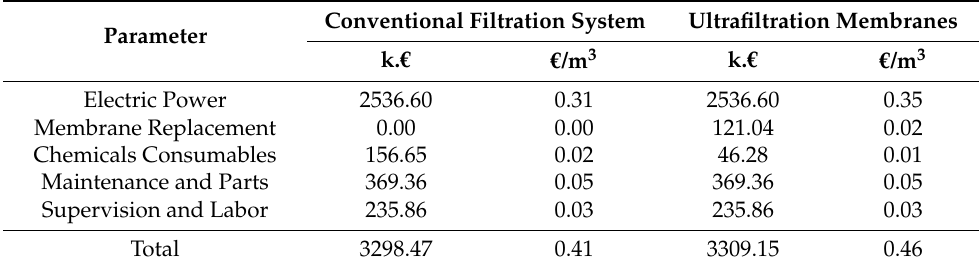
Table 2. Total water cost comparison for the two different treatment